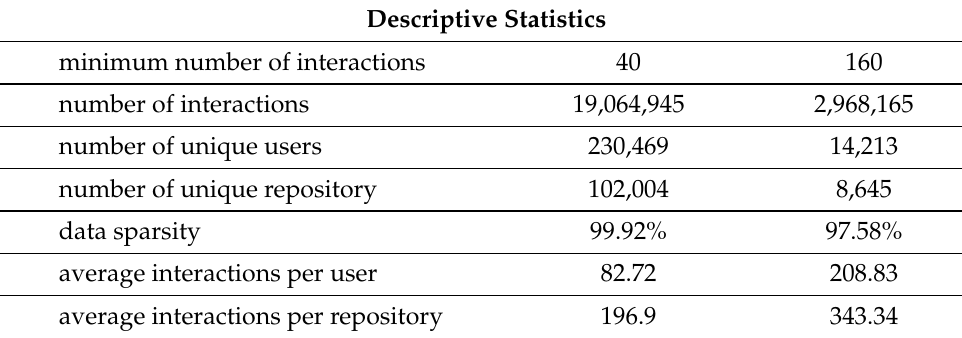
Table 3. Summary of statistics of preprocessed